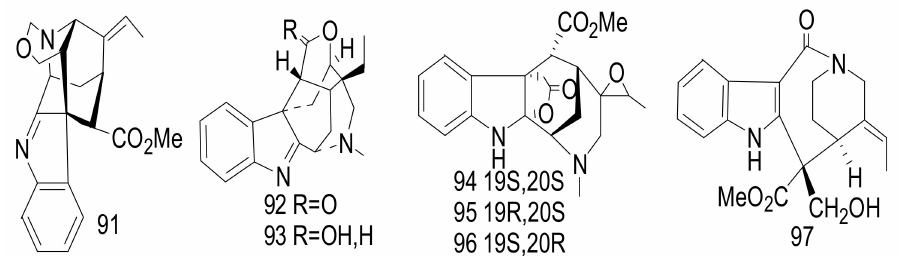
Figure 12. Compounds 91 – 97